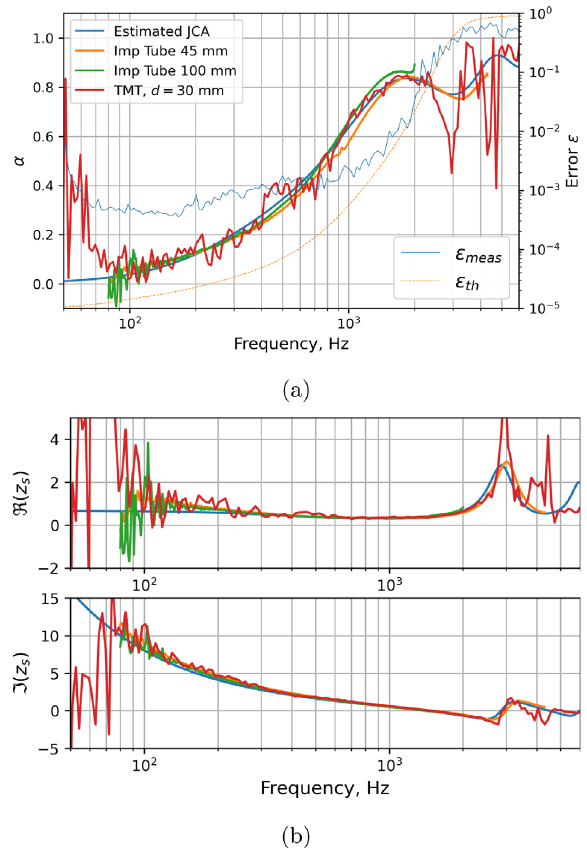
Figure 11. Absorption coef fi cient a and reproduction error e (a), normalized surface impedance z s (b), for the con fi guration shown in Figure 2 at normal incidence with a = 105 cm, b = 60 cm, D m (cid:7) 6.6 cm, h = 0 (cid:3) , / = 0 (cid:3) , z a = 0.5 cm, d = 1.5 cm. (cid:2) k = 10 (cid:3) 7 , (cid:2) k = th : meas :